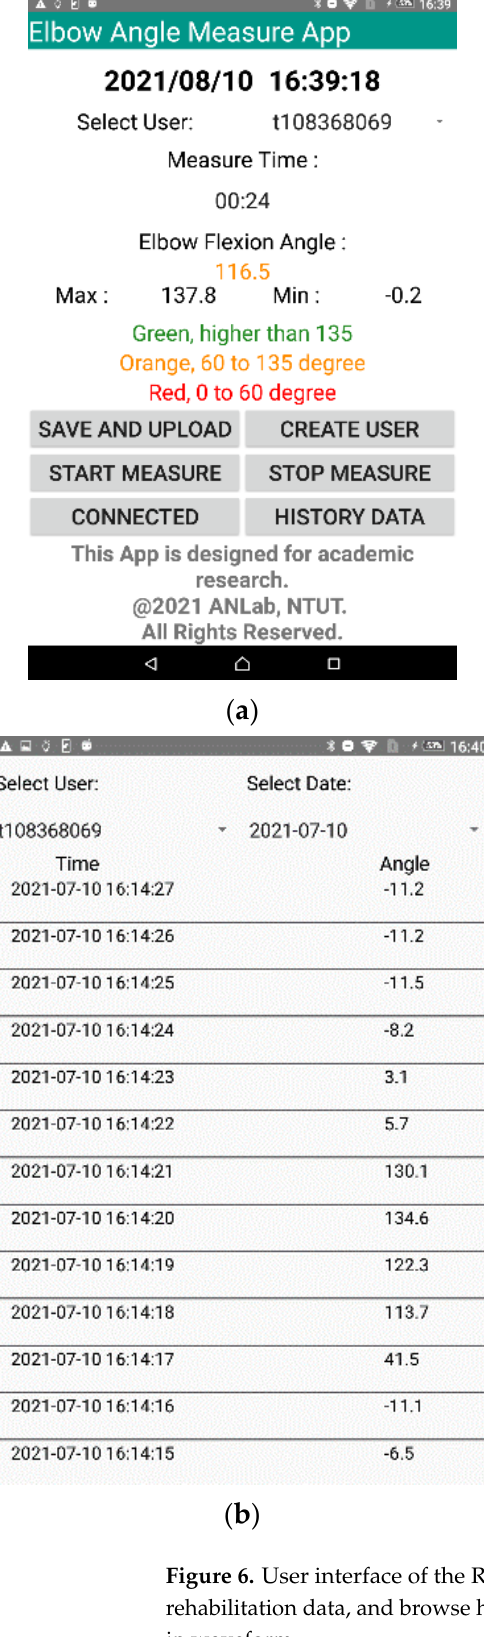
Figure 7. Measurement scenarios of the ROMSS. Since the elbow is the center point for the buckling and stretch of the arm, the angle was measured in a simulated arm by a swivel bracket to evaluate the accuracy of the dynamic measured angle, as shown in Figure 8. In Figure 8, the educational fake arm was simulated as a human forearm. The rotation point of the swivel bracket was simu- lated as the human elbow. The swivel bracket was simulated as a human upper arm. The anticlockwise rotation of the simulated arm defined the buckling as a positive value. The clockwise rotation of the simulated arm defined the stretch as a negative value. The motion range of the simulated arm was constrained by the C-type metal clip. Since the maximal rotation range of the simulated arm was smaller than the maximal angle of the C-type metal clip due to a smaller simulated arm, the deviation of the measured angle in the simulated arm was deleted. Our system could limit the range of movement of the simulated arm by using metal clips based on the actual ROM of the human body and references.